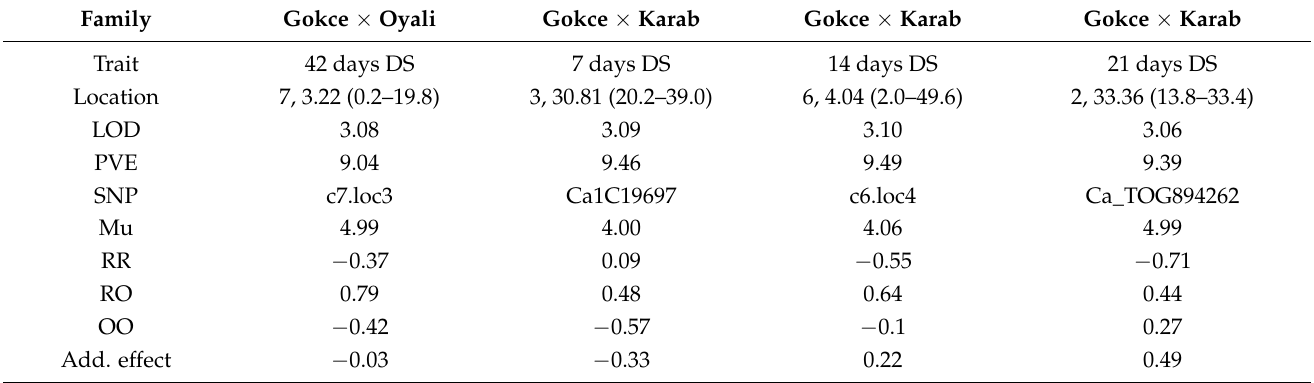
Table 2. Summary of quantitative trait loci for Ascochyta resistance for the chickpea Gokce × Oyali and Gokce × Karab families. Notes. Locations are described by chromosome number, position in 1M bp units, and 1.5 logarithm of odds (LOD) confidence limits in parentheses. PVE is the percentage variance explained. SNP is marker nearest to the QTL peak. SNPs named c#.loc# were not directly genotyped but are genotype probabilities at 1M bp map intervals. Mu is the model predicted mean trait value. Genotype effect sizes on the mean phenotype are summarized as R for the reference cultivated allele and O is the other wild allele. Genotype RO is a measure of the dominance effect. The additive effect is calculated as (OO –